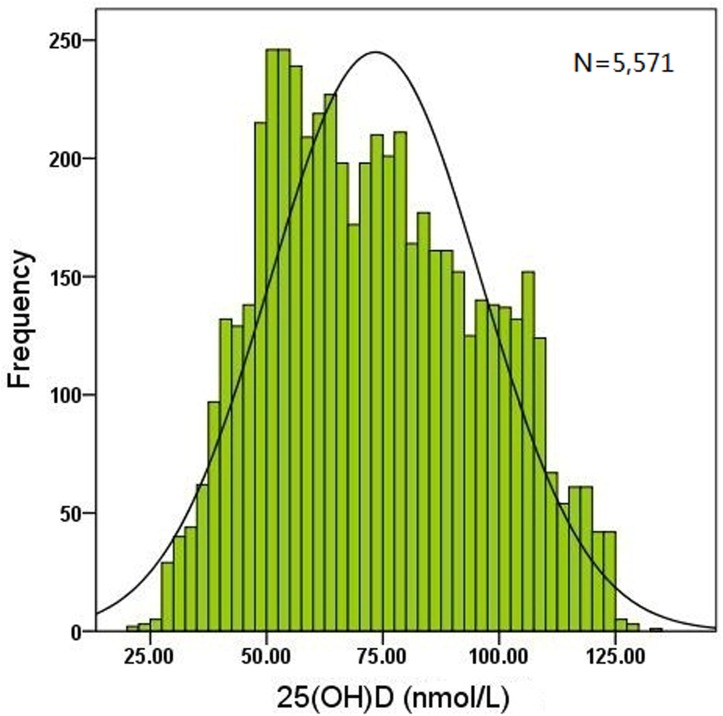
Frequency distribution of the serum 25(OH)D concentration in 5,571 young children.The serum 25(OH)D level ranged from 20.6–132.9 nmol/L with a median value of 71.5 nmol/L and most values of 25(OH)D levels were more than 50 nmol/L.